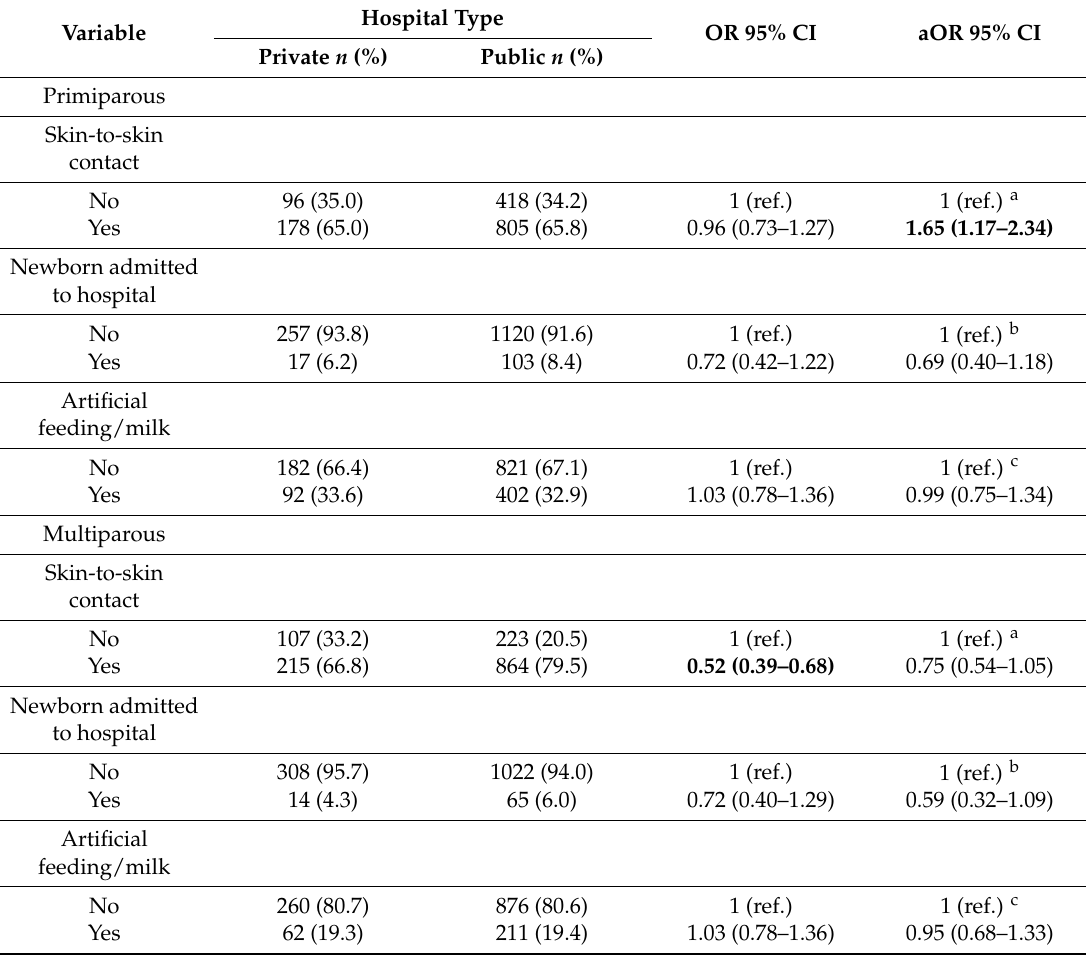
Table 4. Association between the type of hospital (public or private) where delivery occurs and the probability of some clinical practices in the